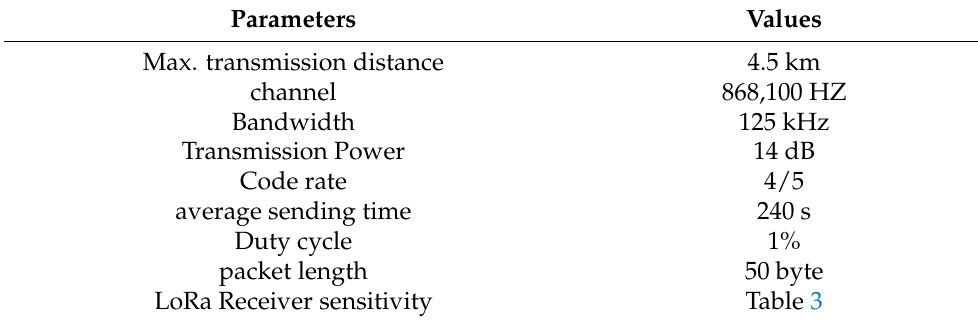
Table 2. Europe LoRaWAN parameters.